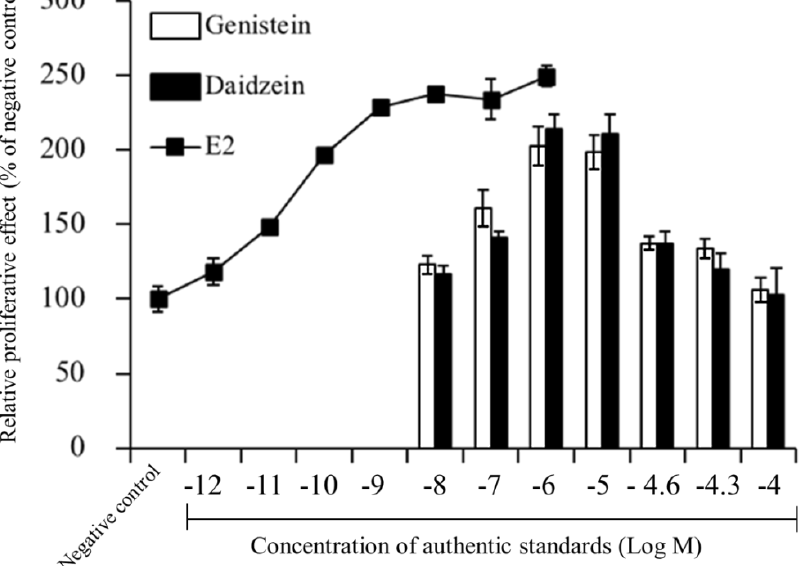
Figure 3. Estrogen-like activities determined in MCF-7 cells of E 2 , genistein and daidzein, p < 0.01, Figure 3. Estrogen - like activities determined in MCF - 7 cells of E 2 , genistein and daidzein, p < 0 . 01, p < 0.001 compared to negative control (C). Each value represents the mean ± SD, n = p < 0 . 001 compared to negative control (C) . Each value represents the mean ± SD, n = 3 .